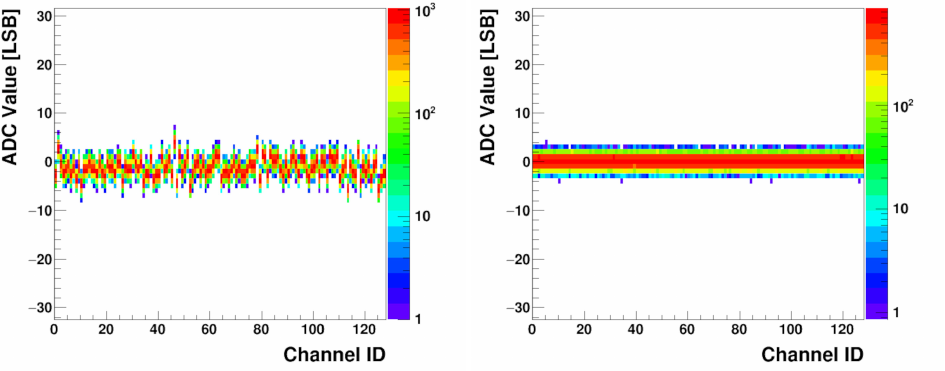
Figure 16. Baseline noise histogram before applying the trim DAC correction ( left ) and after the trim DAC correction ( right ), both with a biased UT sensor attached.